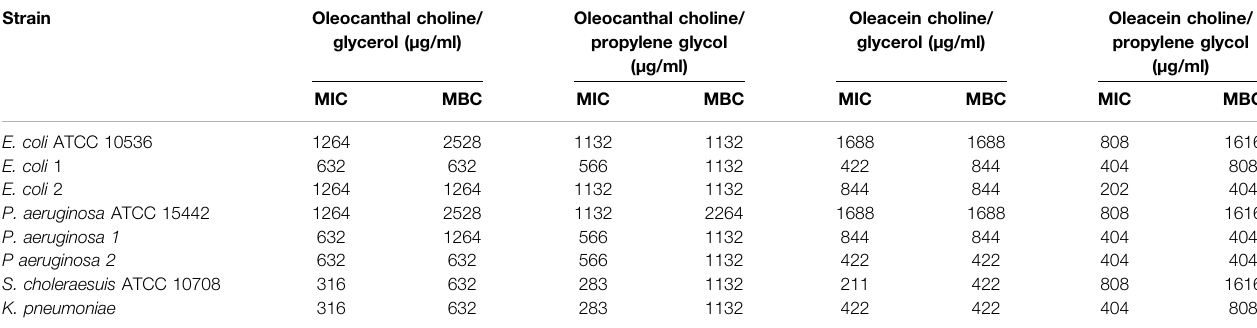
TABLE 7 | Antibacterial activity of oleocanthal and oleacein in NaDESs against Gram-negative standard strains and drug-resistant clinical isolates.